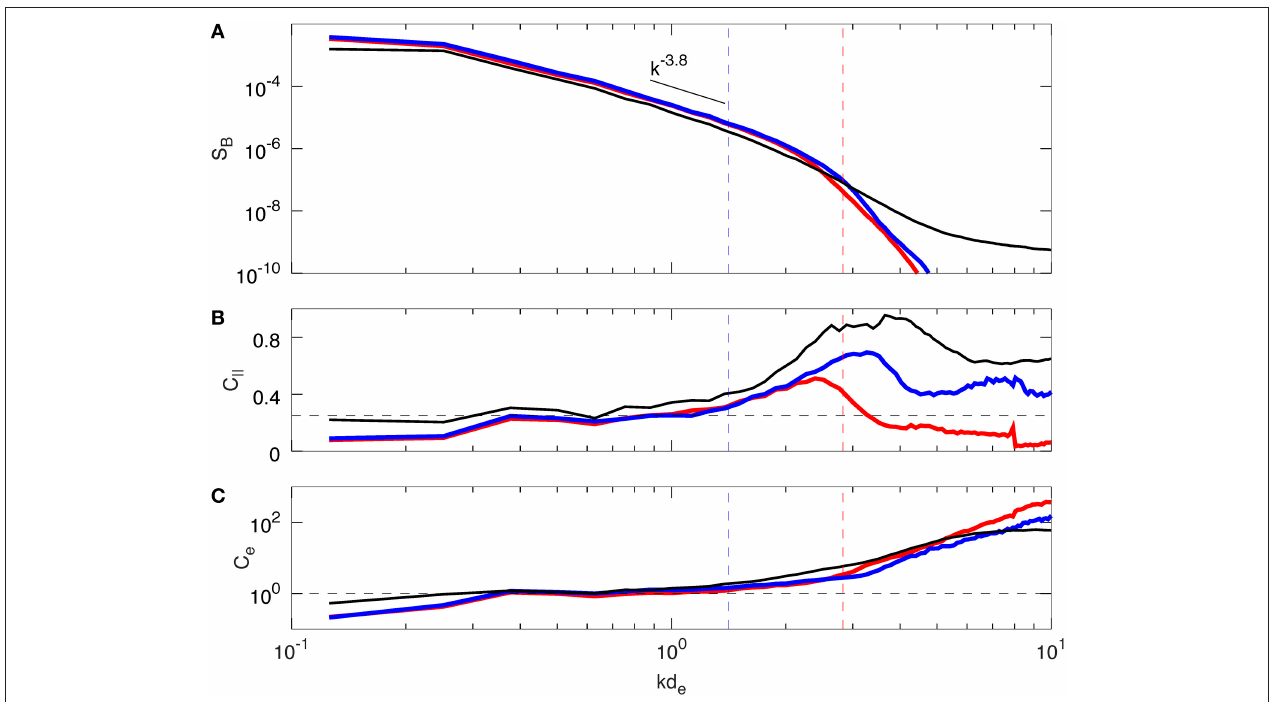
FIGURE 5 | Spectrum of magnetic fluctuations (A) , parallel compressibility (B) , and electron compressibility (C) at t (cid:127) ci corresponding to k ρ e 1 and k λ e 1. The horizontal lines in (B,C) mark values representative of KAWs. In all panels, the blue and red curves correspond to SPS = = simulations with N h 6 and N h 5 respectively. The black curves represent PIC simulation. The top panel also shows a characteristic local slope of the magnetic = = spectrum in the vicinity of kd e ∼